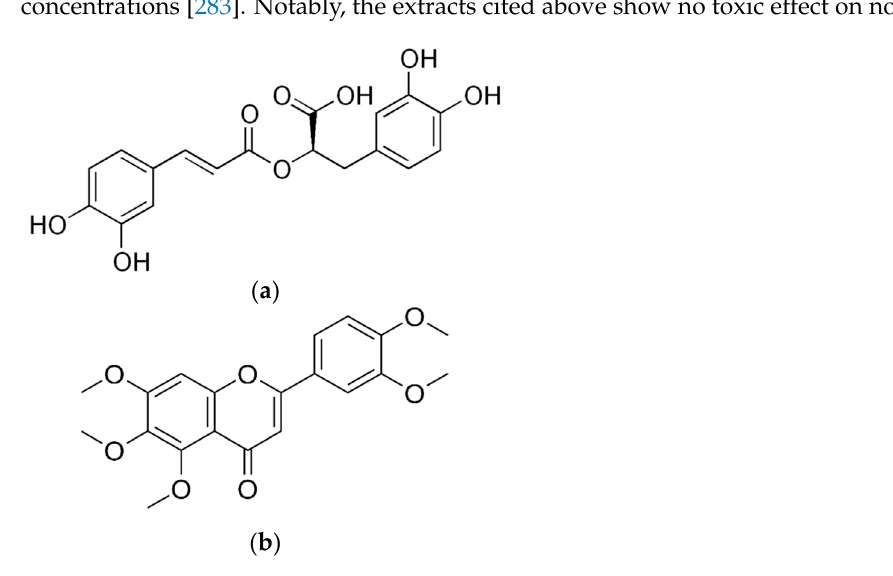
Figure 7. Chemical structure of rosmarinic acid ( a ) and sinensetin ( b ) present in O. aristatus.